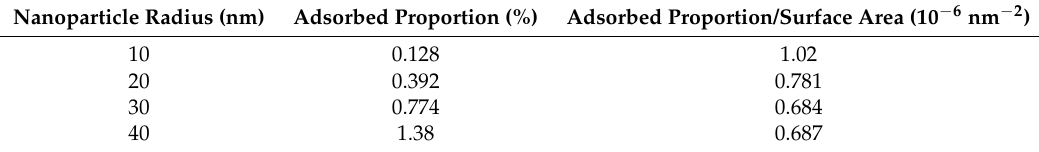
Table 5. The adsorbed proportion of the α C-chain of fibrinogen per surface area in simulations with a single nanoparticle with different radii when the surface charge density is − 0.001 e /Å 2 . Nanoparticle Radius